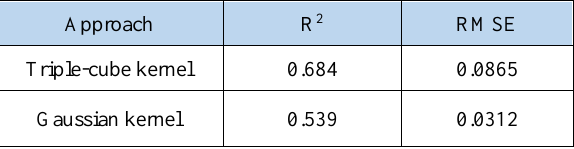
Table 3. Accuracy criteria based on two